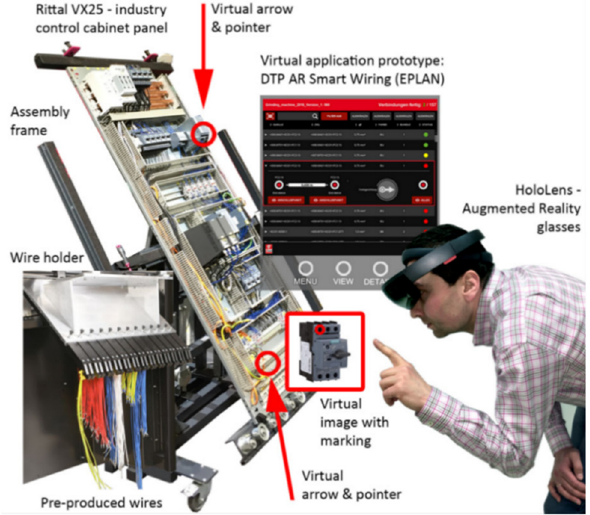
Figure 8. Overview of the production station and general system principle